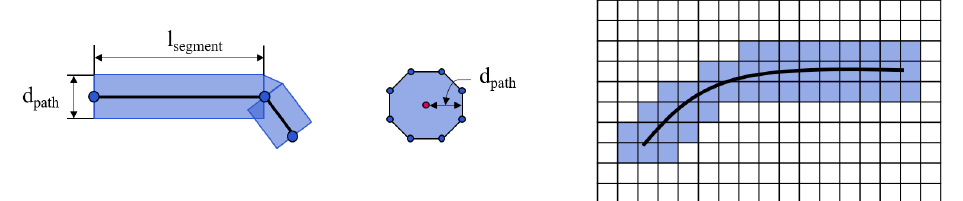
Figure 12. Two path segments ( left ); a path interruption ( middle ); and coverage calculation grid ( right ).